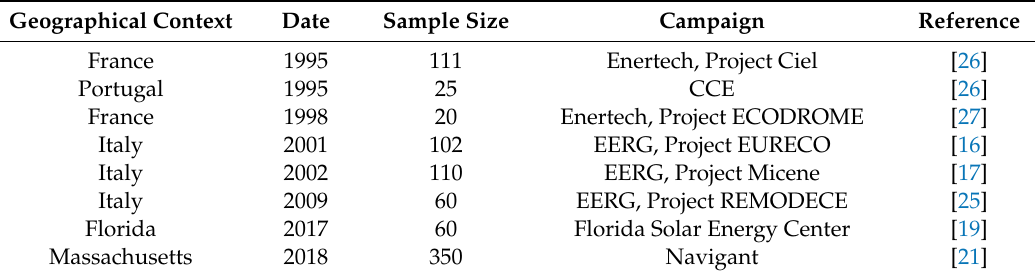
Table 1. Sample size in previous monitoring